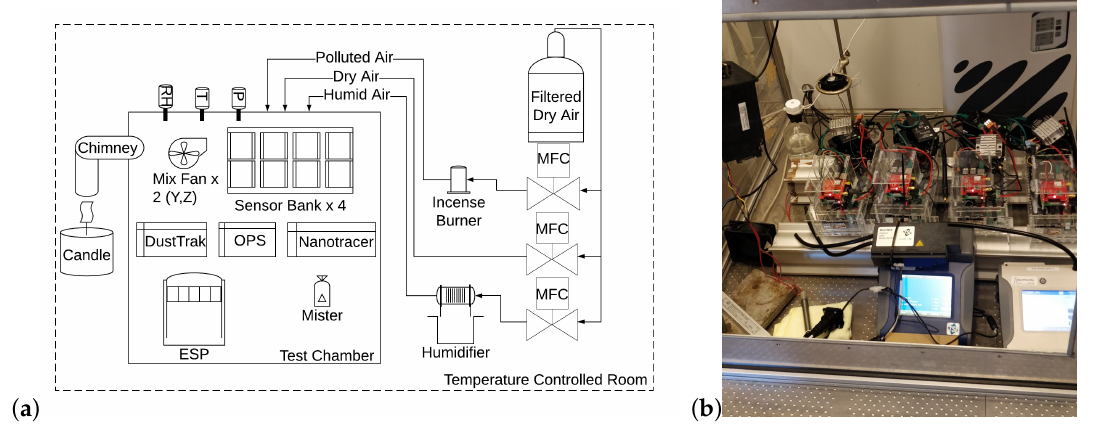
Figure 2. ( a ) Schematic showing the arrangement of the test chamber and supporting equipment. ( b ) Image showing the air quality boxes located in the test